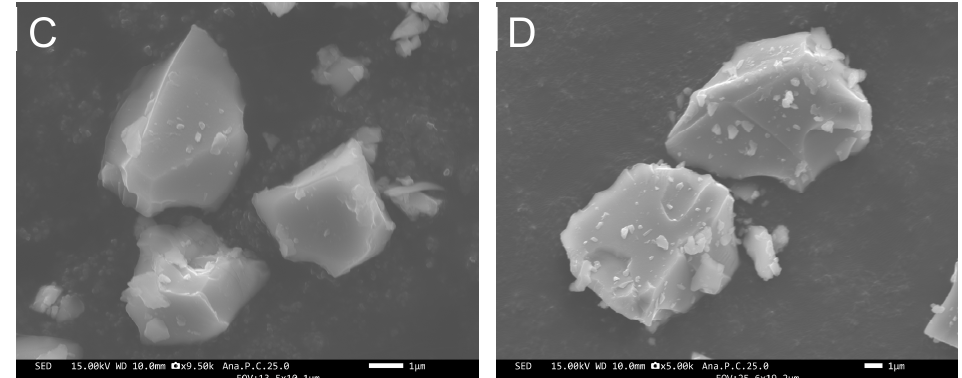
Figure 1. FE-SEM images of the glass particle surfaces of ( A ) Cont, ( B ) PG-1, ( C ) PG-2, and ( D ) PG-3. 93